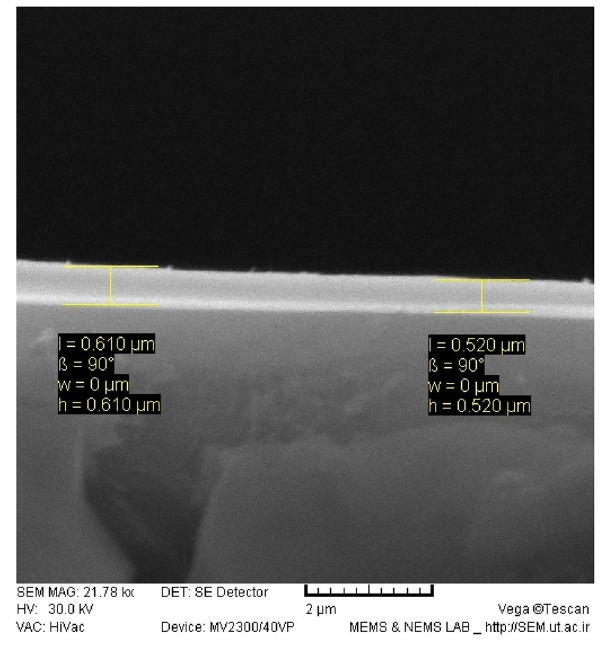
Fig. 3 Thermal oxidation of Si substrate (at 1050 °C) with 0.5 μm thickness